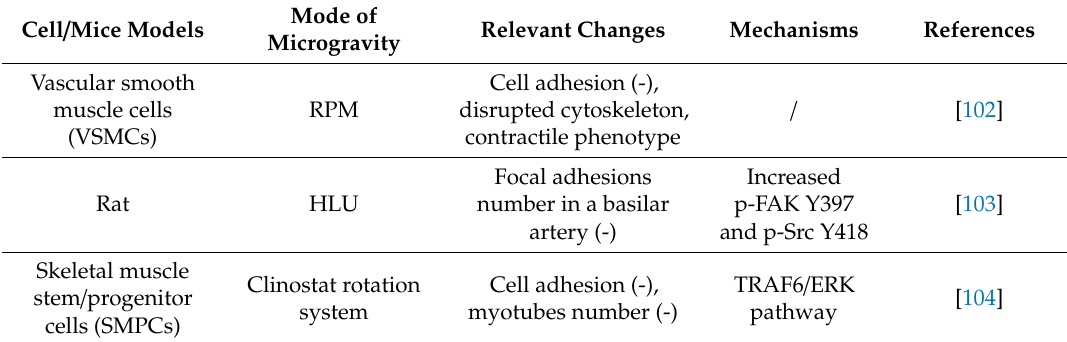
Table 7. E ff ects of microgravity on muscle cells